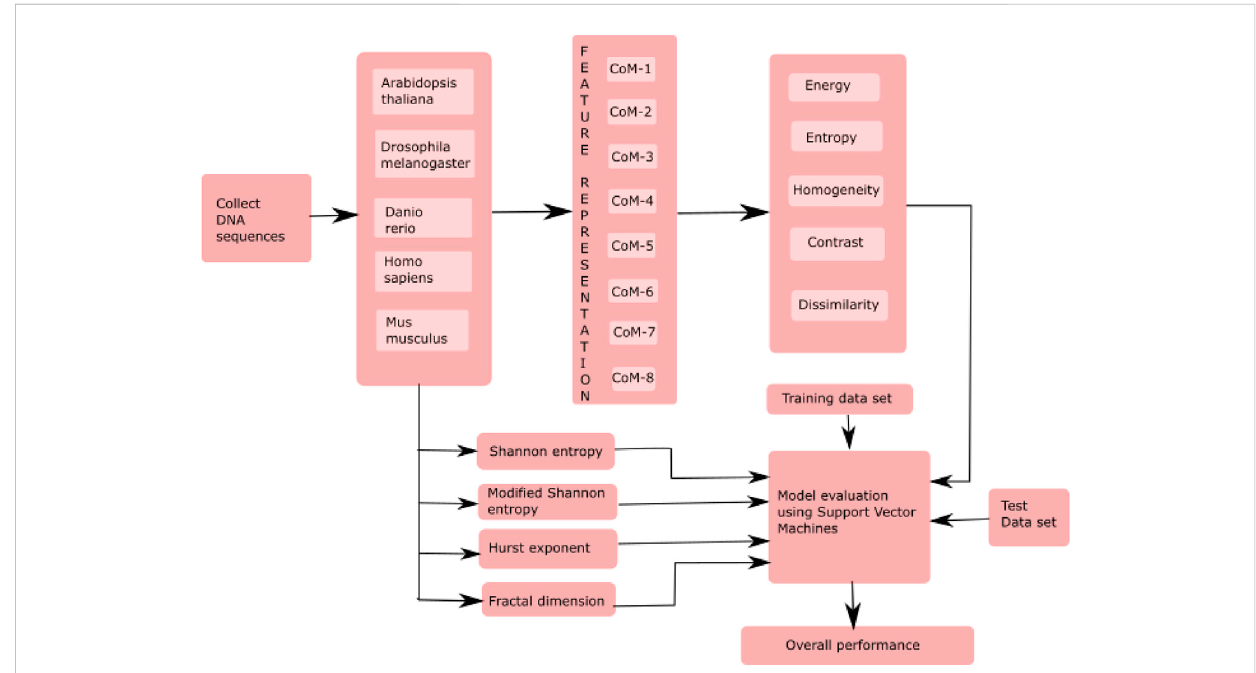
FIGURE 1 Framework of the proposed model for the classi fi cation of essential genes. Here, CoM indicates the co-occurrence matrices.